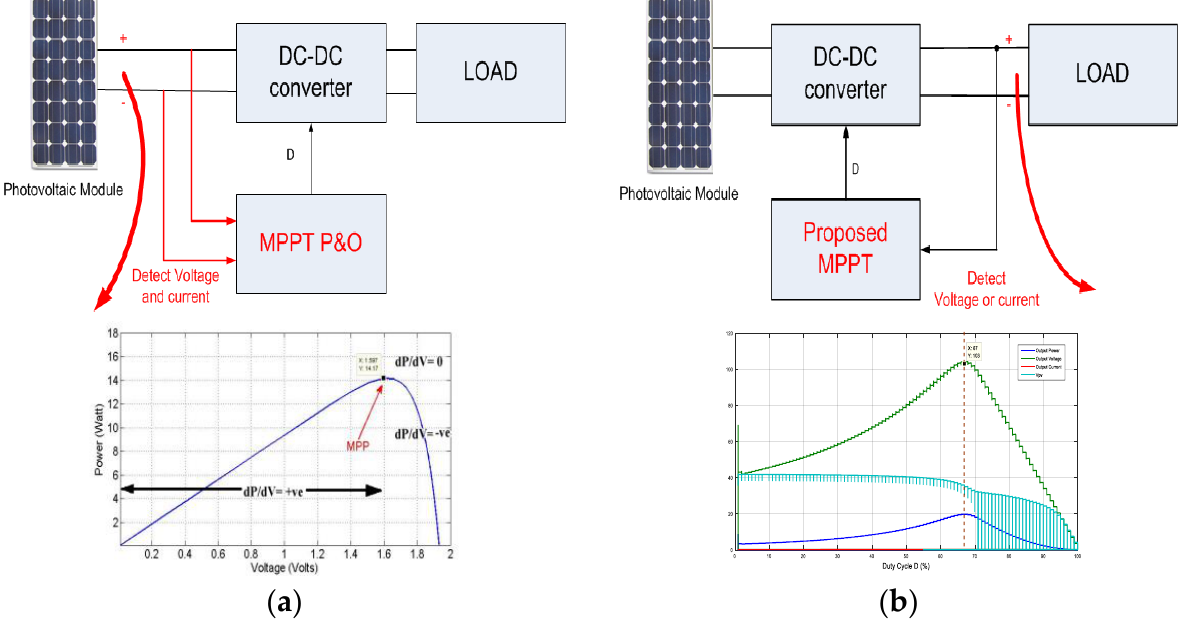
Figure 7. Comparison of ( a ) conventional P&O method with ( b ) proposed method in terms of sensing parameters. Table 2. Methodology of the proposed